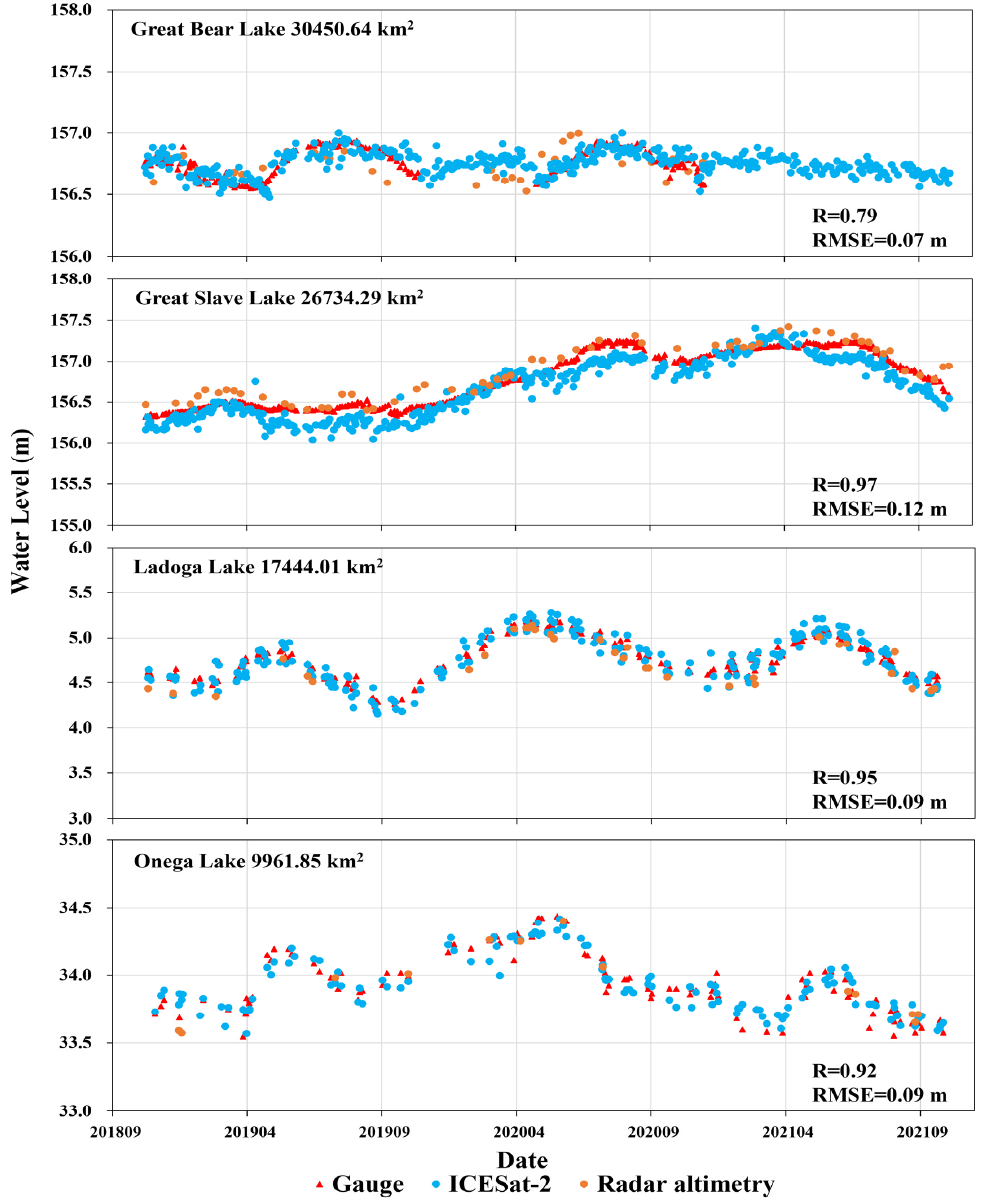
Figure 8. Comparison of water levels from the ICESat-2 and radar altimeters, and gauge stations for four selected lakes (Great Bear Lake and Great Slave Lake in NA, Ladoga Lake, and Onega Lake in EURA) with long-time series ICESat-2 observations.